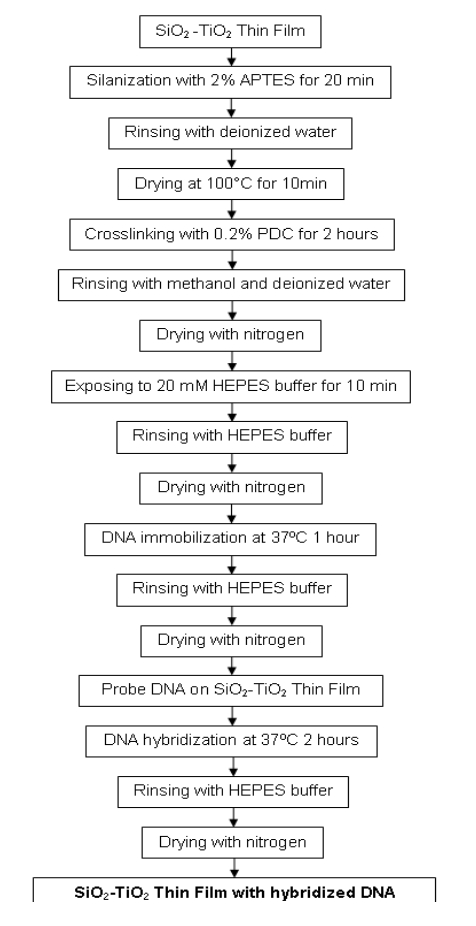
Figure 2. The flowchart of DNA immobilization and hybridization